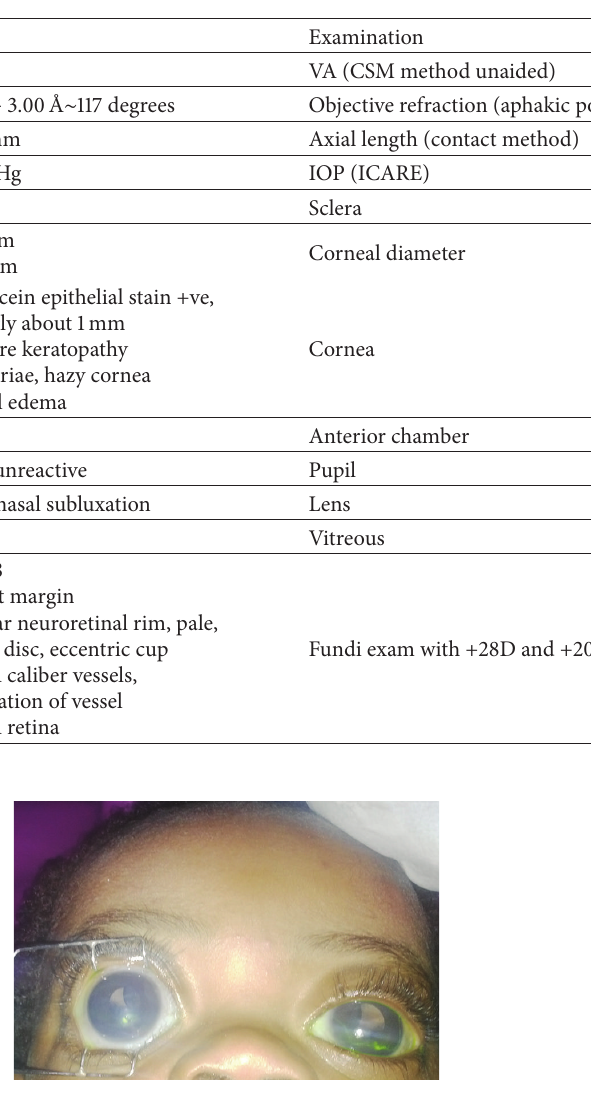
Table 1: Findings at first presentation in the children’s clinic.